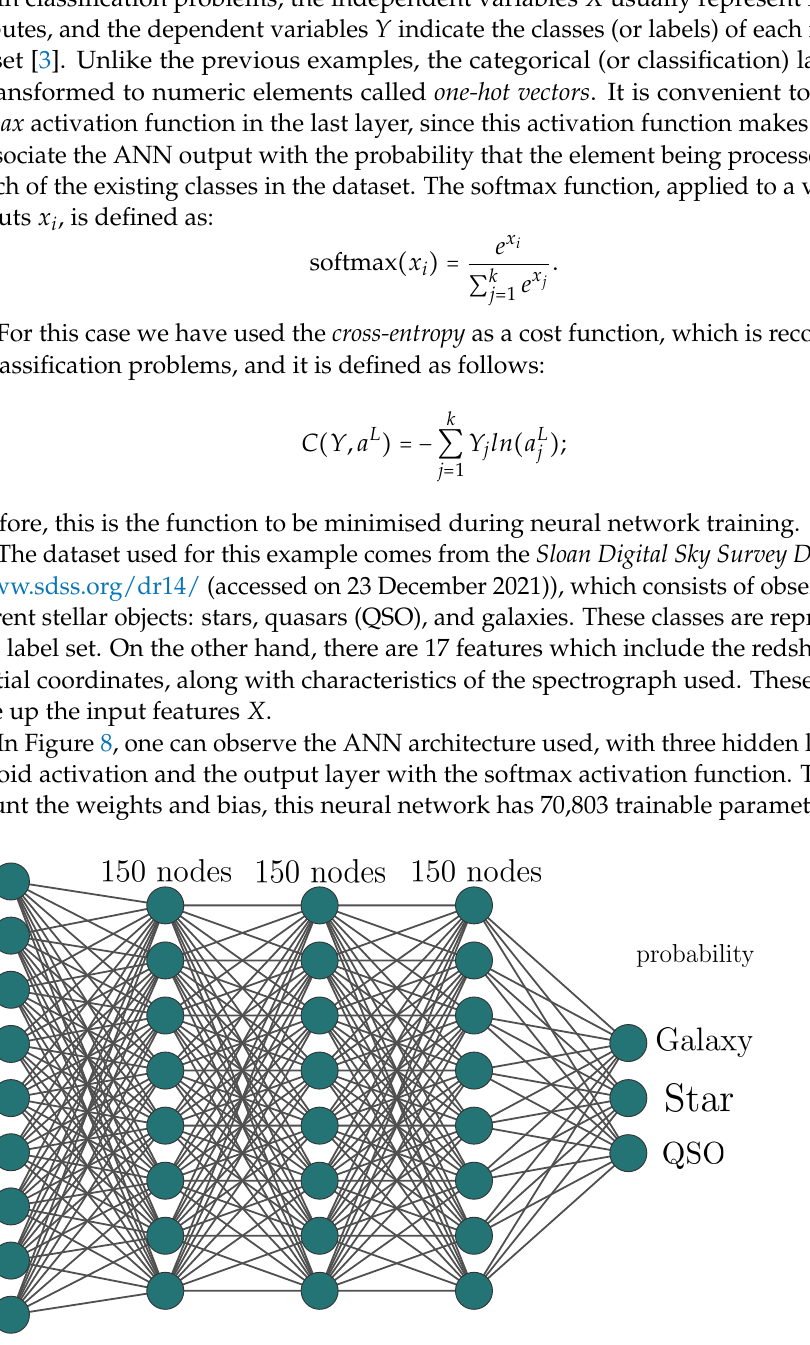
Figure 8. The ANN architecture used for the classification of astronomical objects. The input layer reads the attributes of the SDSS dataset and the output layer corresponds to the probability that each record is a given astronomical object, whether star, galaxy, or